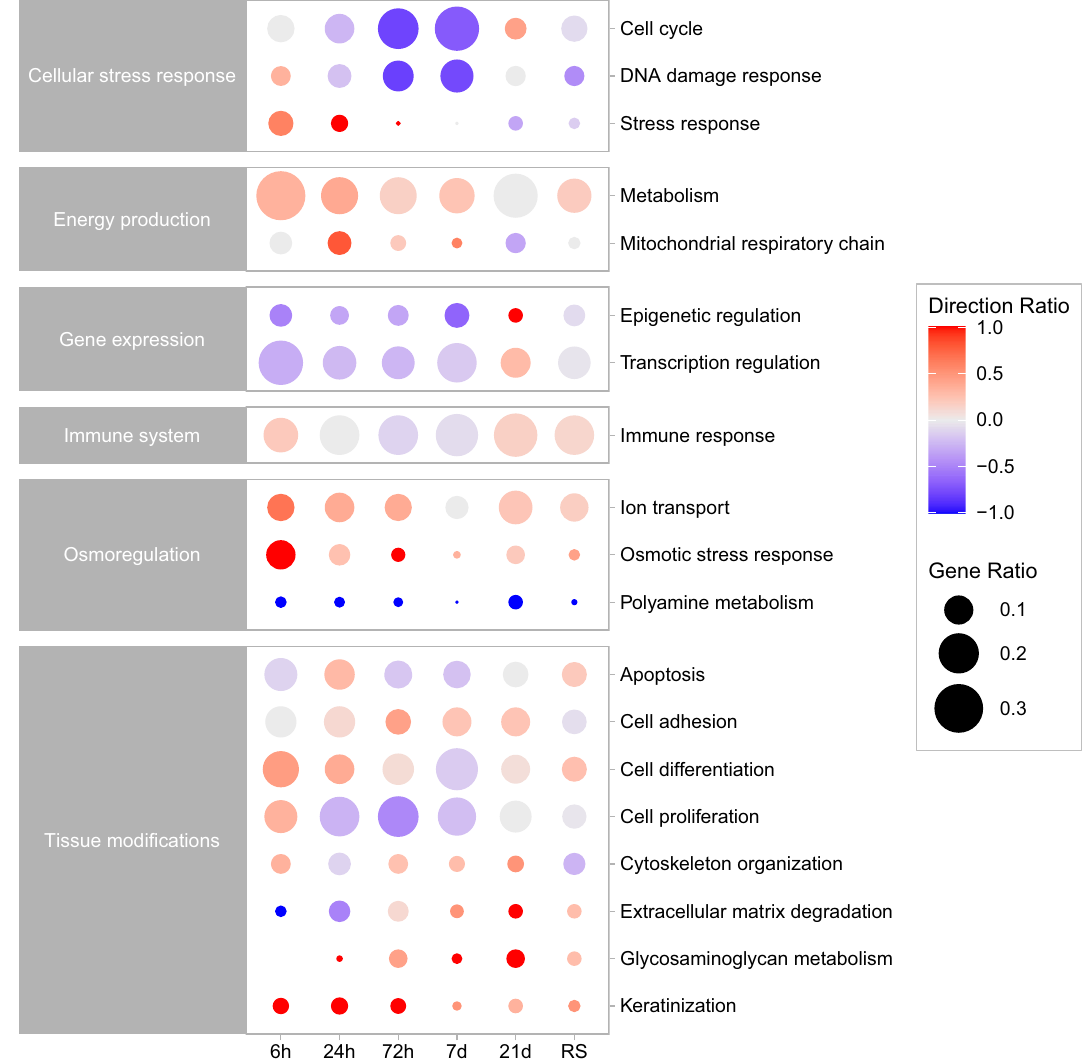
Figure 6. Changes in ratio and expression direction of differentially expressed genes grouped by functions along the acclimation timeline. Circle sizes are proportional to the gene number ratio for a specific function at a certain time point. Circle colours correspond to the ratio of the upregulated (red circles) vs downregulated (blue circles) genes for the function at that time point; the fuller the colour, the higher the proportion of up- or downregulated genes (e.g. 1.0 = all genes are upregulated; 0 = half of the genes are upregulated, half are downregulated; − 1.0 = all genes are